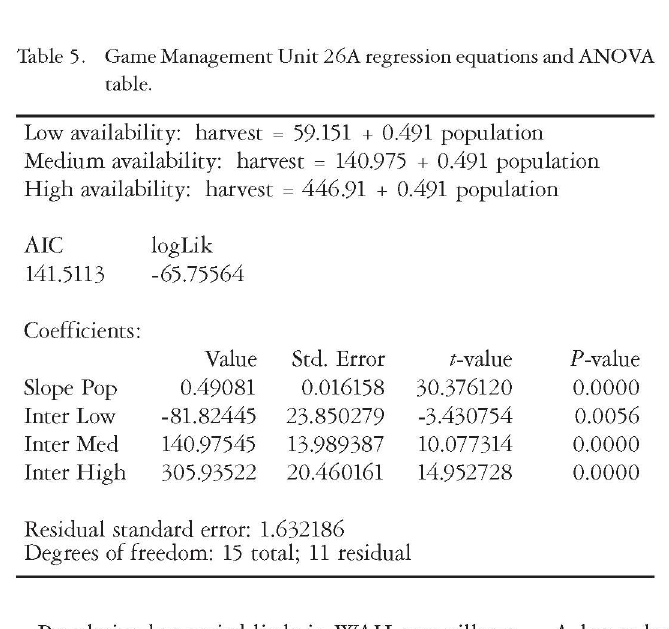
Table 5. Game Management Unit 26A regression equations and ANOVA table.